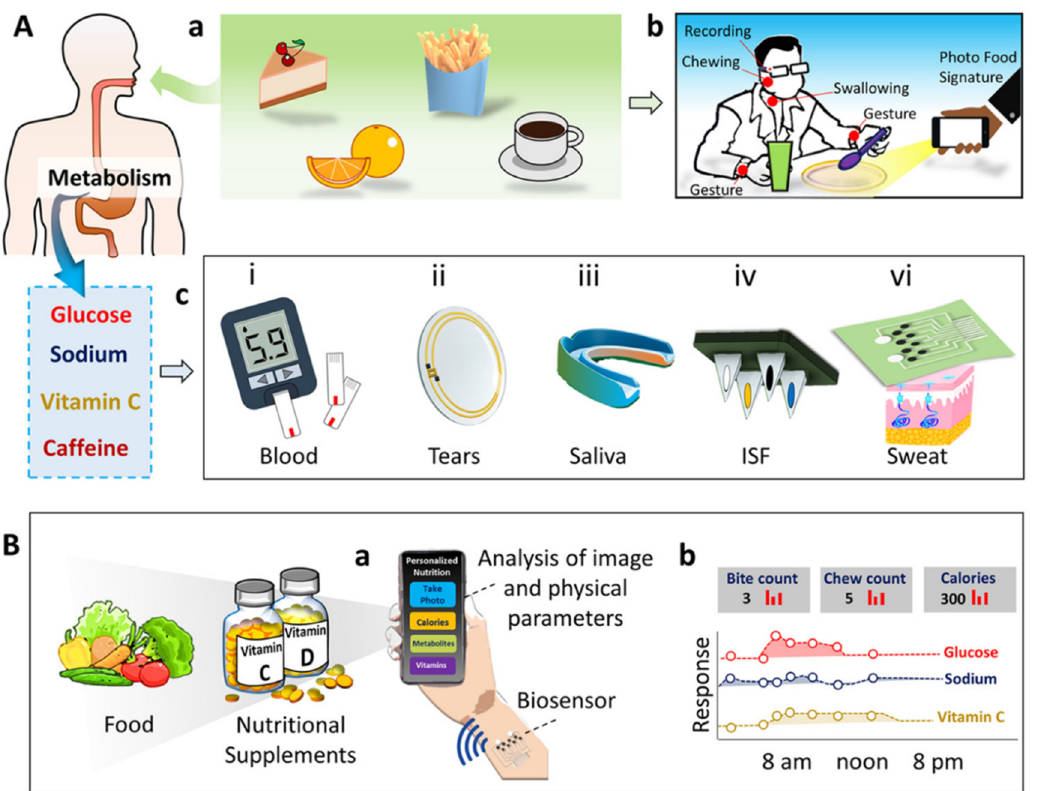
Figure 12. Concept of personalized nutrition measurement system. ( A ) Monitoring food intake ( a ) and ingestion behavior ( b ). Wearable sensing of metabolites in human biofluid ( c ). ( B ) Schematic representation of comprehensive nutrient-monitoring system for simultaneous monitoring of nutrients present in the food and metabolites in humans. (Reproduced with permissions from the American Chemical Society) [118].